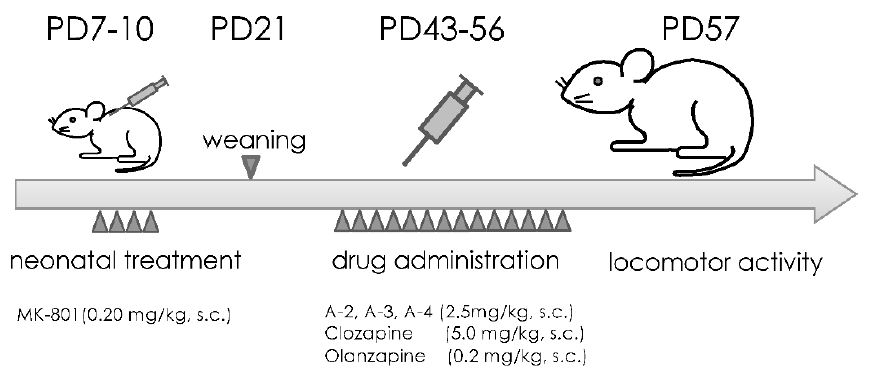
Figure 2. Schematic representation of experiments for neonatal treatment (MK-801), drug administra- tion ( A-2 , A-3 , A-4 , clozapine and olanzapine) and locomotor activity testing. PD, postnatal